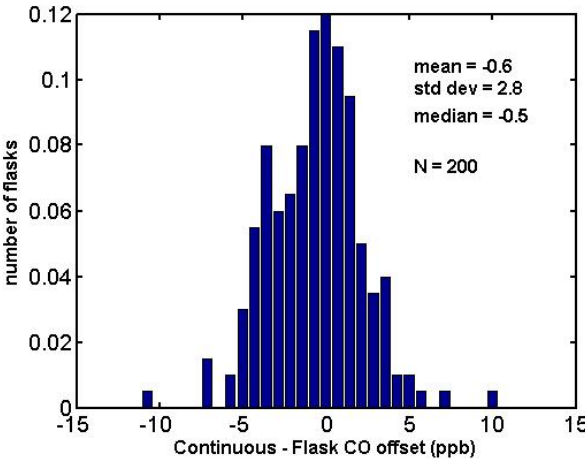
Fig. 11. Differences between continuous (CRDS) CO measure- ments and flask CO measurements during flights over Alaska on the USCG C-130 for 2011. The mean, 1- σ standard deviation, and number of flasks ( N ) are indicated on the